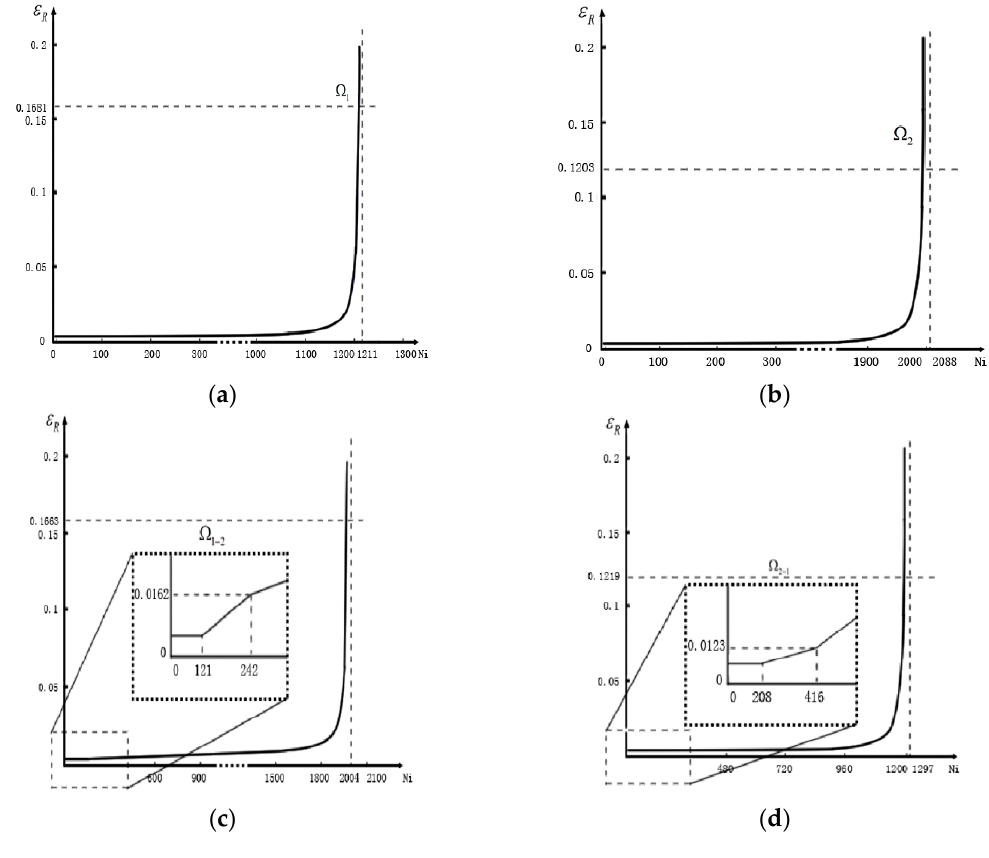
Figure 10. Relation between resistance strain and cycle numbers at T = 298 K under different